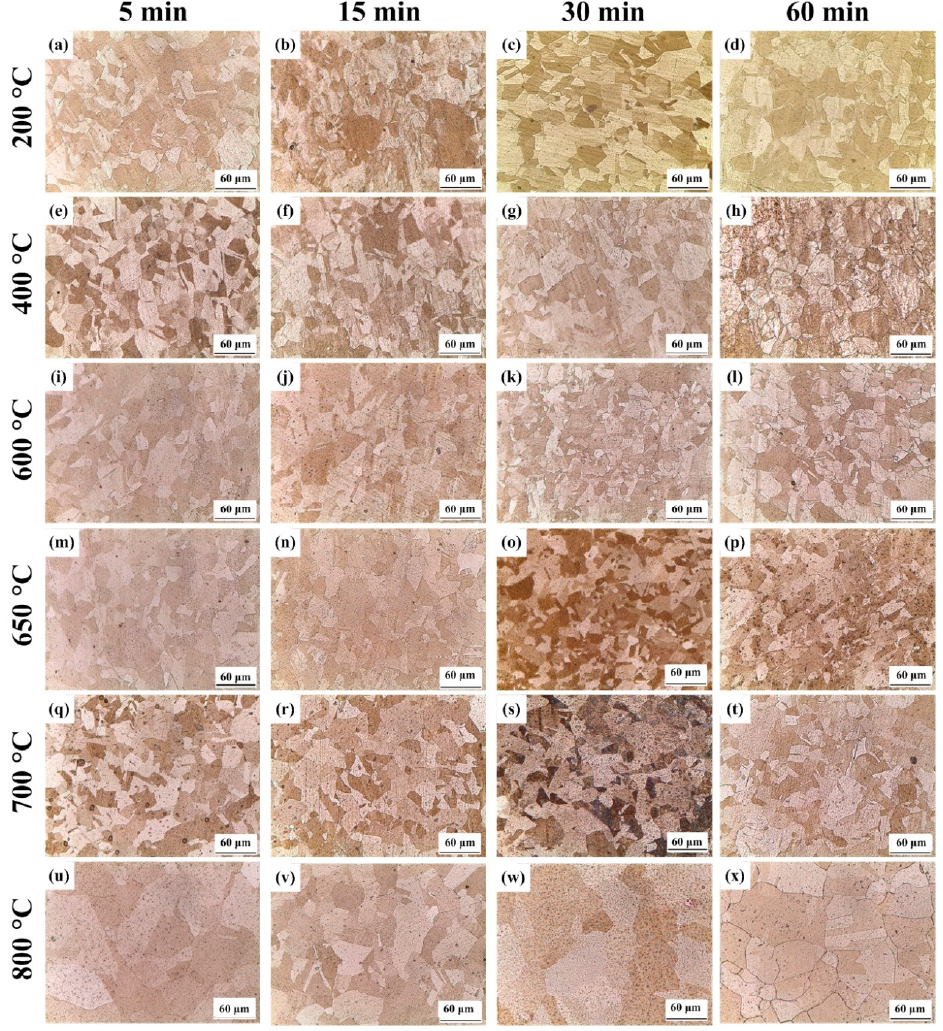
Figure 7. Microstructure of nickel sheets after pass 2 in scheme 2 with subsequent annealing at different temperatures and time.